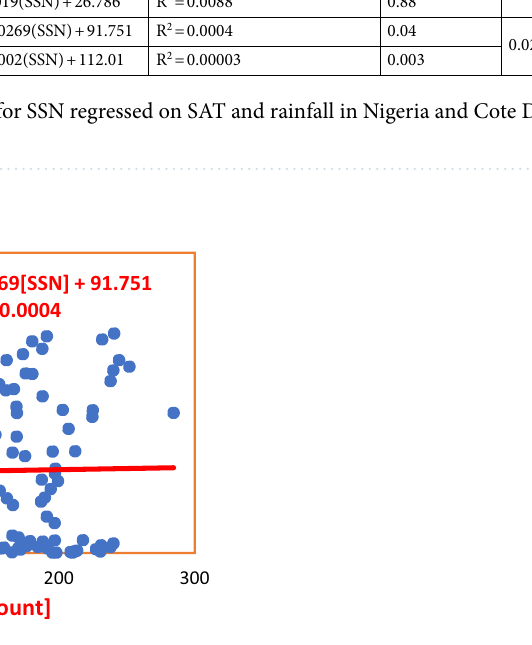
Figure 4. Regression of SSN on Rainfall in PHC during Solar Cycles 22–24. From the Regression Equation, SSN and Rainfall are not well associated. The Coefficient of Determination shows a 0.04% association, which is too insignificant to effect any change in the climate variable of the study area.